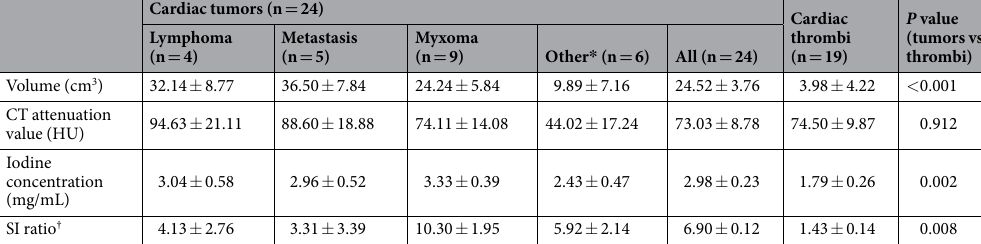
Table 2. Quantitative analysis of dual-energy CT and MRI findings for cardiac tumors and thrombi. Note: Estimated mean ± SE (standard error) by the mixed effects model. * Other tumor included cavernous hemangioma (n = 2), lipoma (n = 2), angiofibroma (n = 1), and papillary fibroelastoma (n = 1). † For SI ratio, sample size was 16 for cardiac tumors and 12 for cardiac thrombi. HU, Hounsfield units; SI, signal intensity.